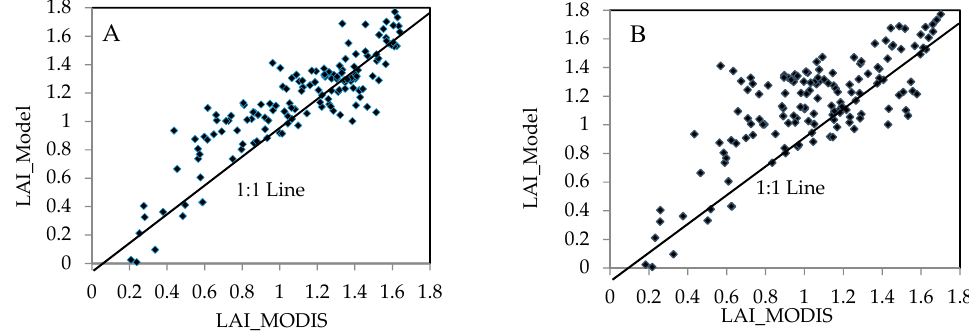
Figure 7. The scatter plots of spatially-averaged MODIS LAI vs. ( A ) LAI_Model with Kriging interpolation of Rainfall; ( B ) LAI_Model with WLS interpolation of Rainfall.